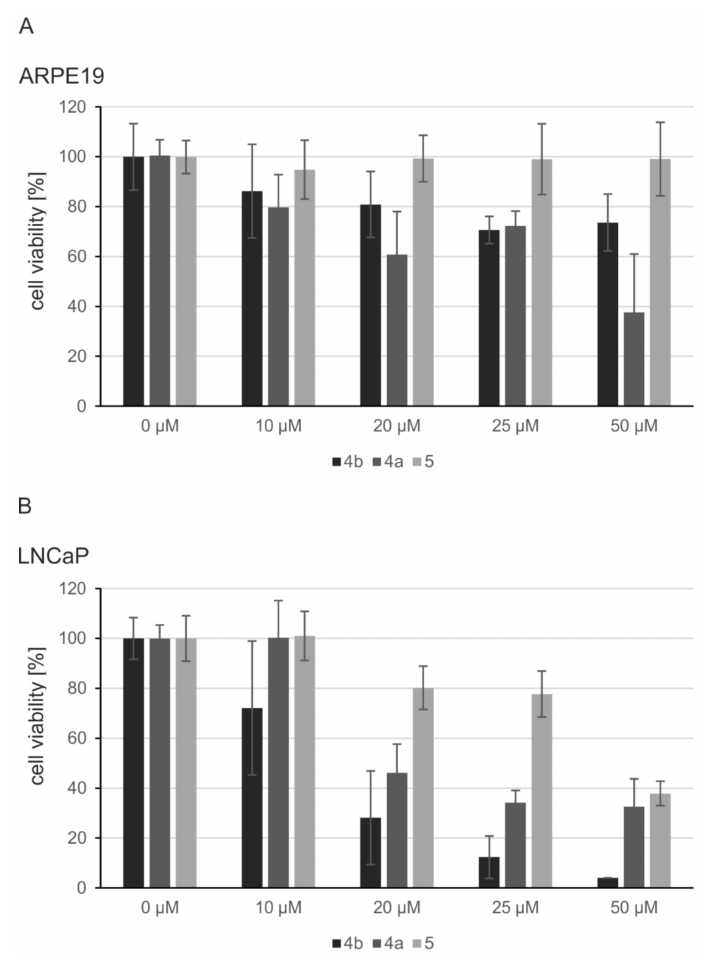
Figure 5. Effects of dibenzofuran inhibitors on cell viability. ARPE19 ( A ) or LNCaP ( B ) cells were incubated with the given concentrations of 4b , 4a , 5 or DMSO as control. Cell viability was determined using the MTT assay after 24 h of incubation. Viability was set in reference with DMSO. The mean and standard deviation of three independent experiments with two technical replicates each is shown.